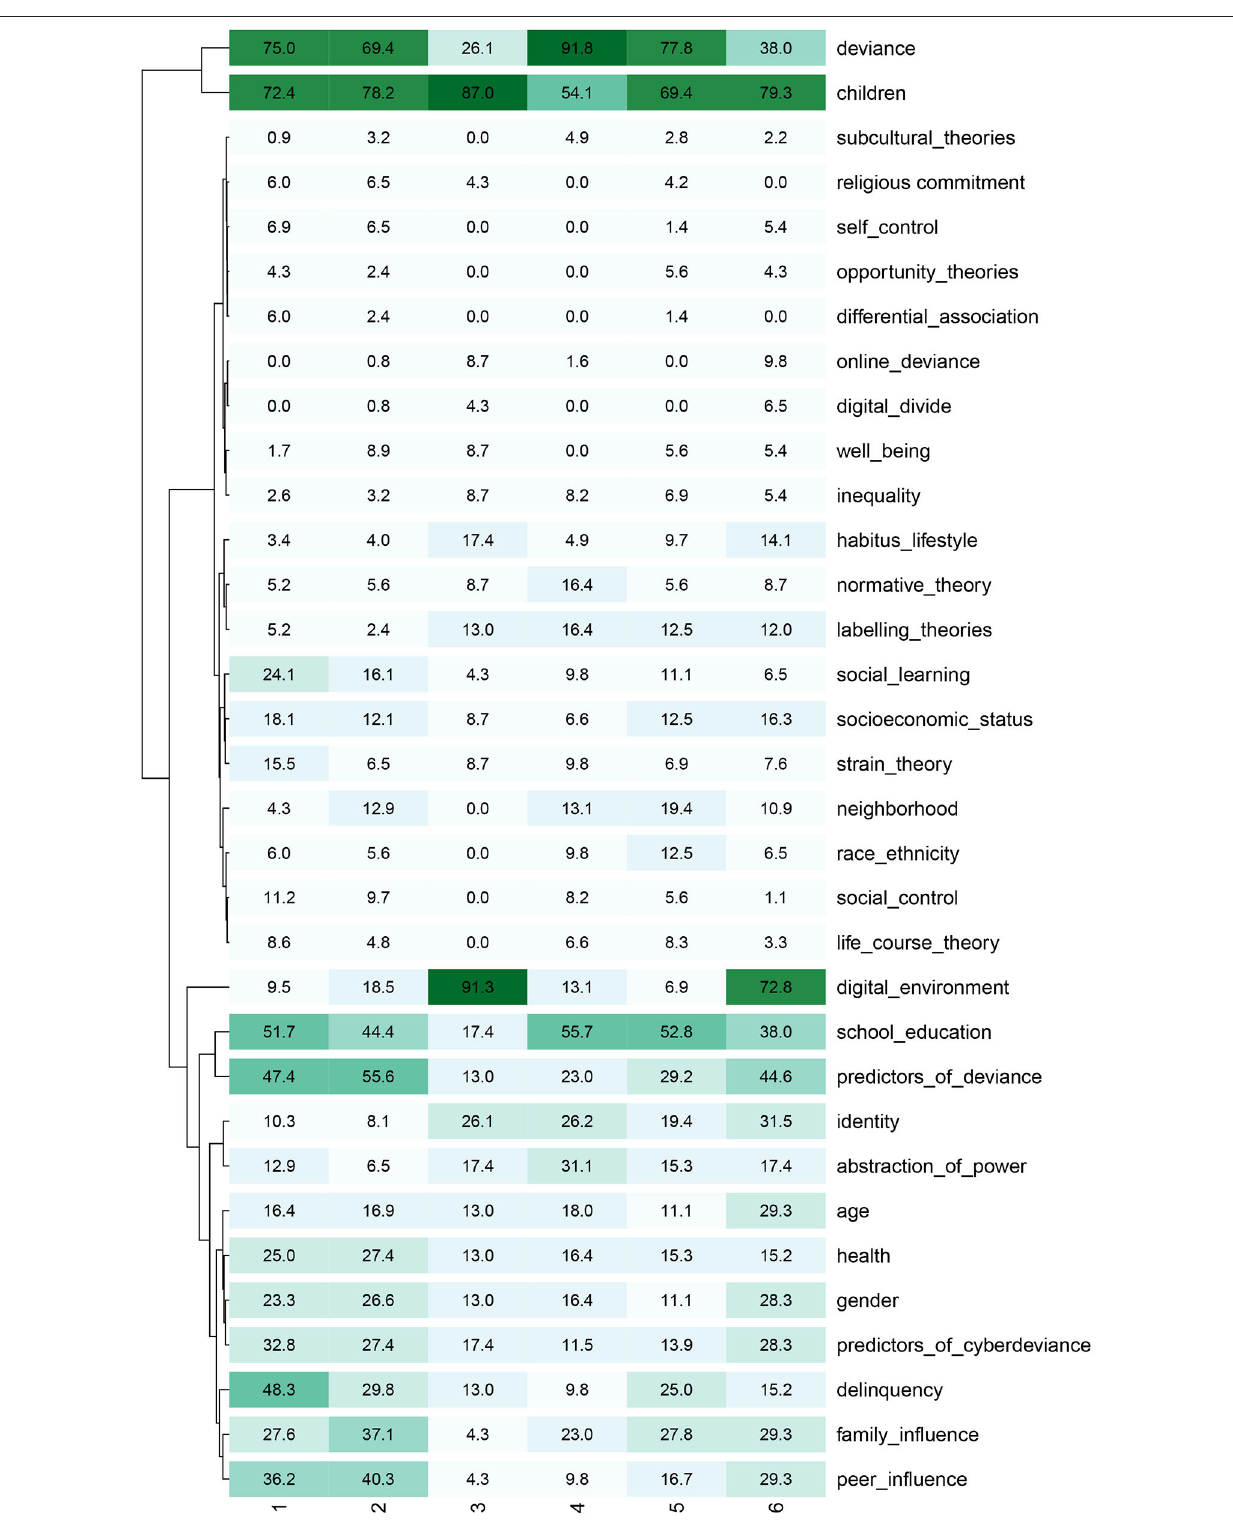
FIGURE 12 | Crosstab bulk articles heatmap